Question: Provide a one-line summary of what is displayed.
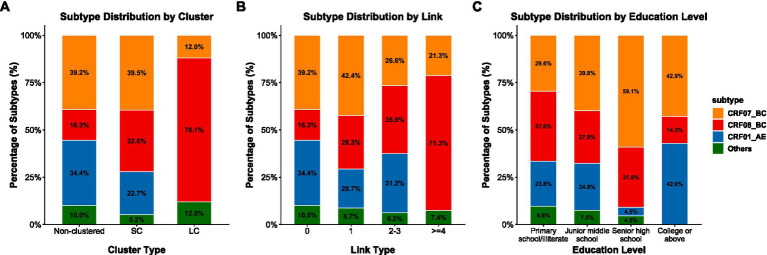
Answer: (A) Subtype distribution categorized by cluster scale: Non-clustered cases, small clusters (SC, <10 nodes), and large clusters (LC, ≥10 nodes). (B) Subtype distribution based on individual node degree (link counts ranging from 0 to ≥4). (C) Subtype distribution stratified by the highest level of formal education achieved by the clustered individuals.